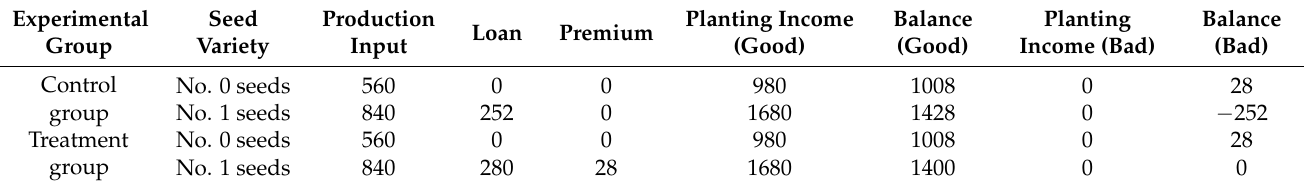
Table A6. Experimental parameter settings comparison of traditional and innovative seeds (Unit: